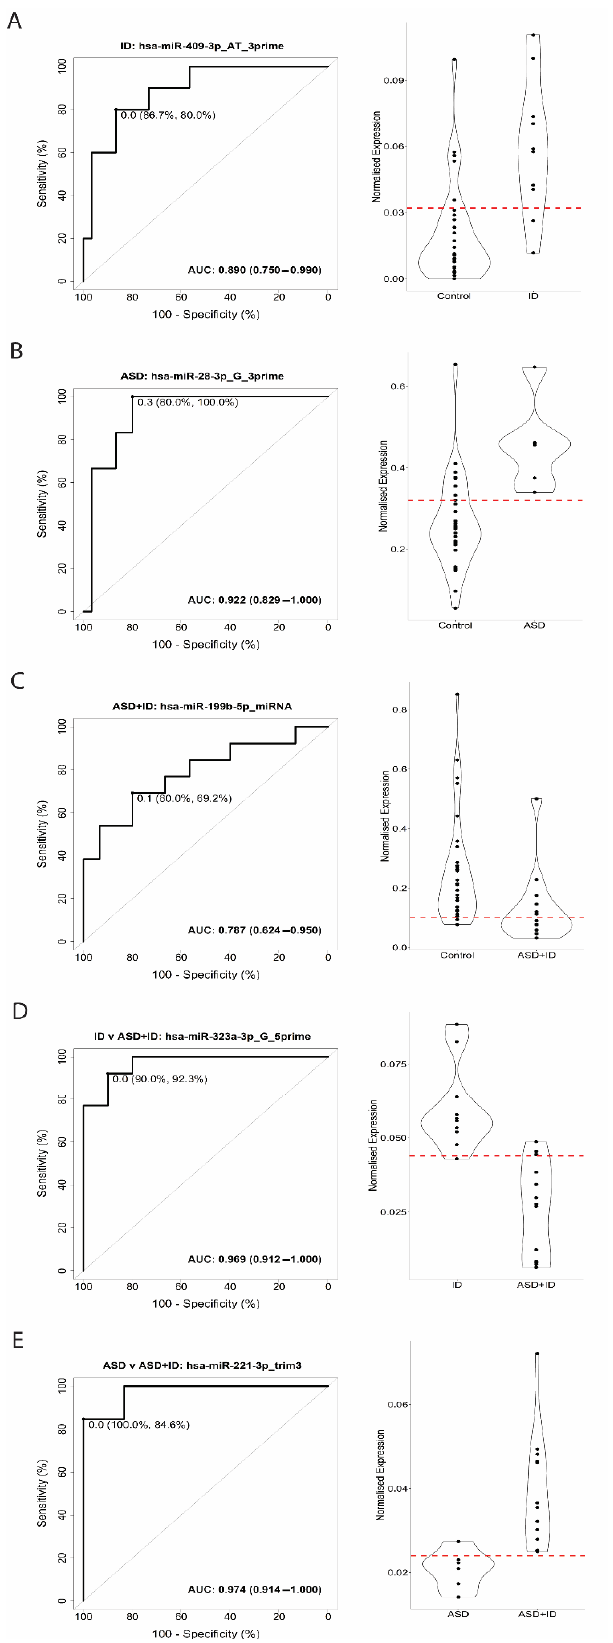
Figure 3. Receiver operating characteristic (ROC) curve analysis and violin plots for Intellectual Disability (ID), and Autism Spectrum Disorder (ASD), ASD + ID, as well as for discriminating